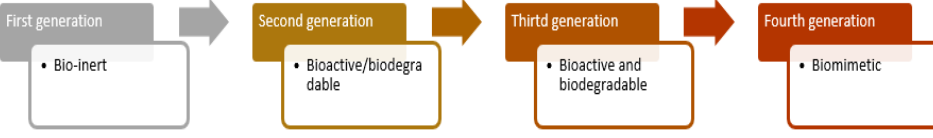
Figure 1. Categories of